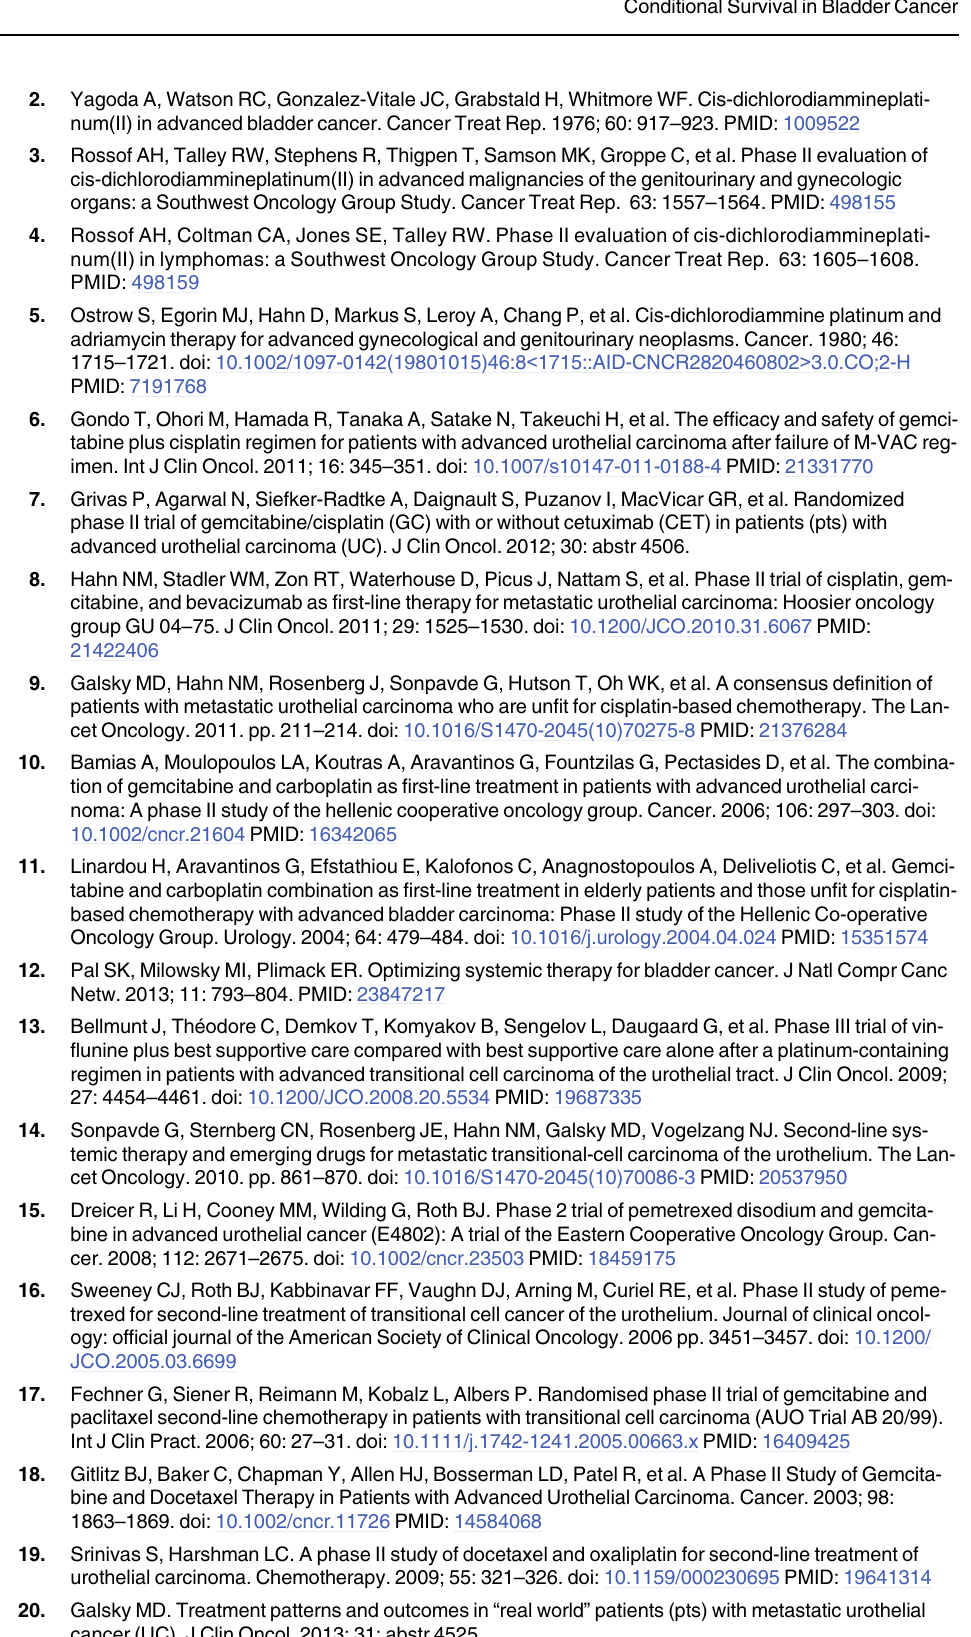
PLOS ONE | DOI:10.1371/journal.pone.0136622 August 26,